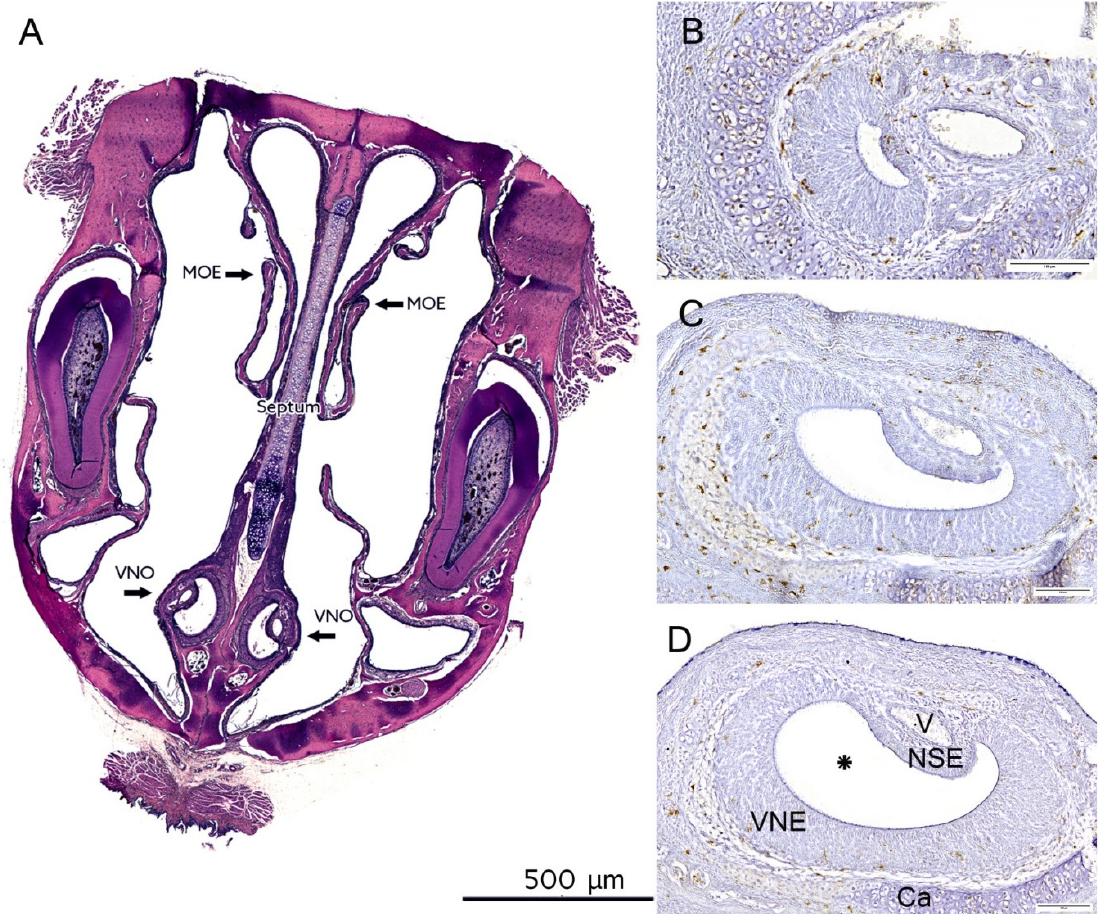
Figure 7. Overview of the vomeronasal organ (VNO) and main olfactory epithelium (MOE) in 3-day-old rats. ( A ) Frontal section across the head of the rat. Samples were subjected to H&E staining. Arrows indicate the MOE and VNO. Scale bar: 500 µ m. ( B – D ) Representative immunohistochemical reactions with Iba1 in different sectional planes of the VNO. The semilunar-shaped VNO consists of a vomeronasal duct (*), sensory vomeronasal epithelium (VNE), non-sensory epithelium (NSE), vomeronasal cartilage (Ca), vomeronasal nerve and glands (not indicated). V = vein. After Witt and Wo´zniak [29]. Samples were counter-stained with hematoxylin. Scale bar: 100 µ